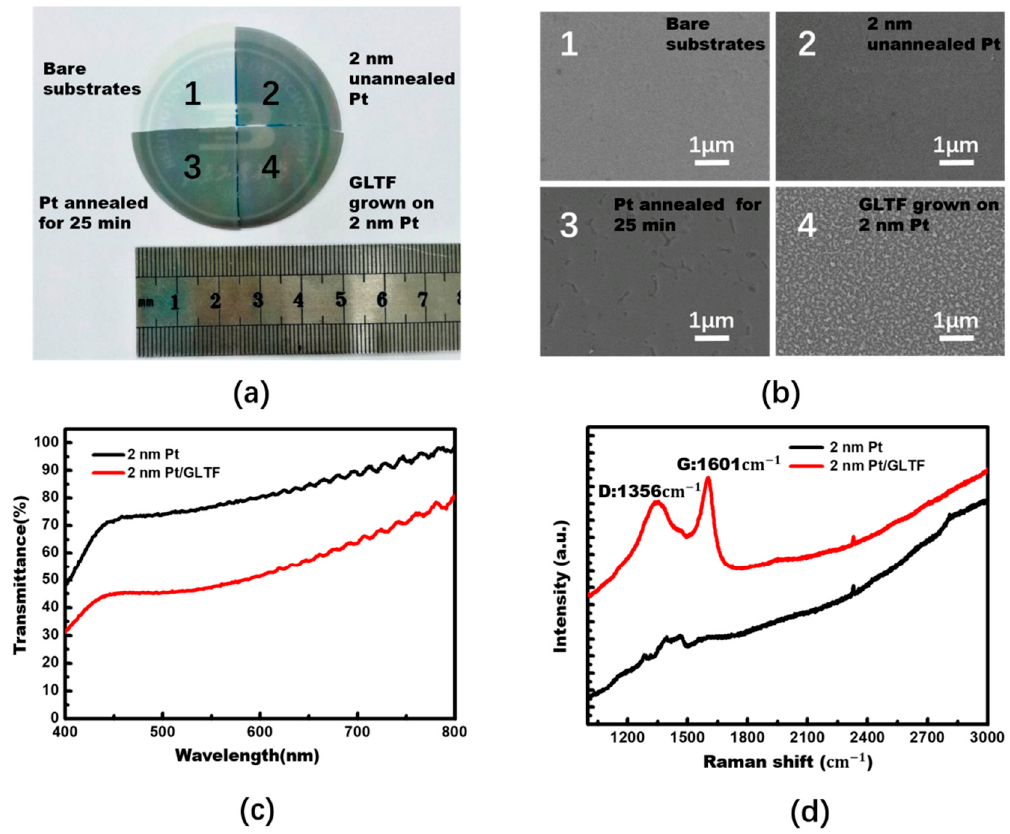
Figure 3. ( a ) Shows GaN LED samples of bare substrates, with 2 nm unannealed platinum, with platinum annealed for 25 min, and with GLTF grown on 2 nm platinum (samples 1–4). ( b ) Shows morphological scanning electron microscope (SEM) images of the four samples. It is clear that the platinum surface roughness increased after annealing. ( c ) Shows the transparencies of the GaN LED epiwafers with 2 nm Pt / graphene (sample 4) and 2 nm Pt (sample 2) in the 400–800 nm range. ( d ) Shows a Raman comparison diagram of samples 2 and 4.